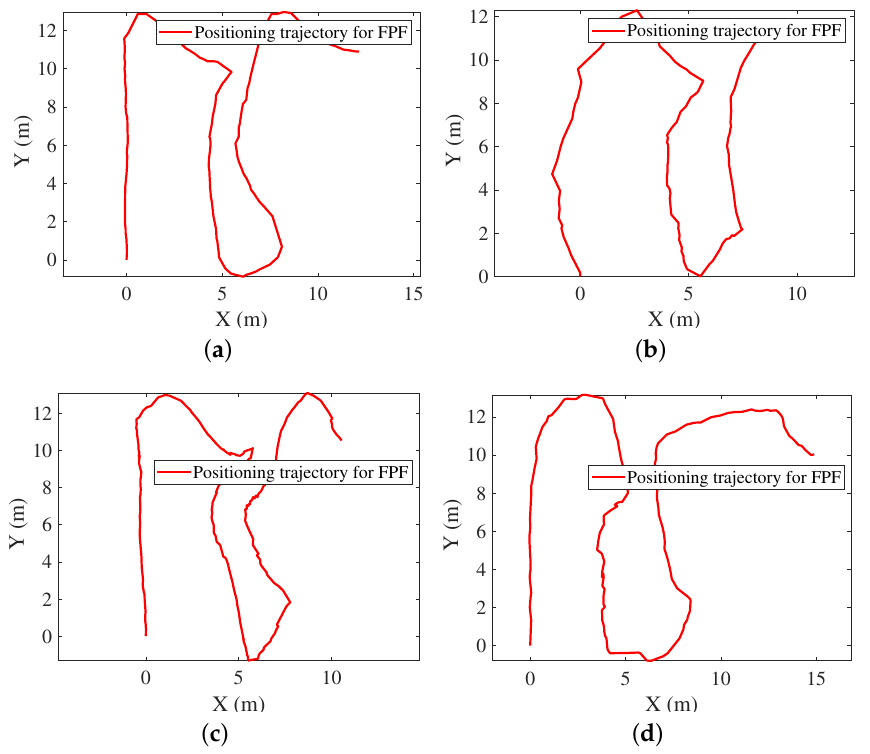
Figure 6. Navigation trajectories for FPF. ( a ) Calling mode. ( b ) Dangling mode. ( c ) Handheld mode. ( d ) pocketed